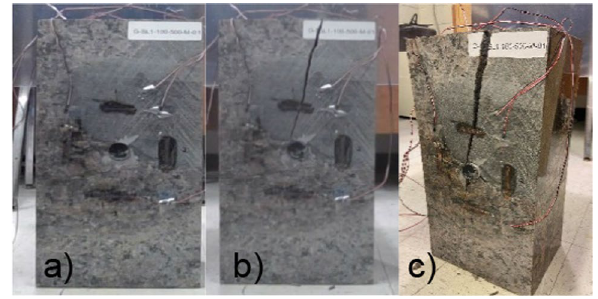
Fig. 6 G-SL1-100-500-M-03 a At time t Complete breakage at t 27